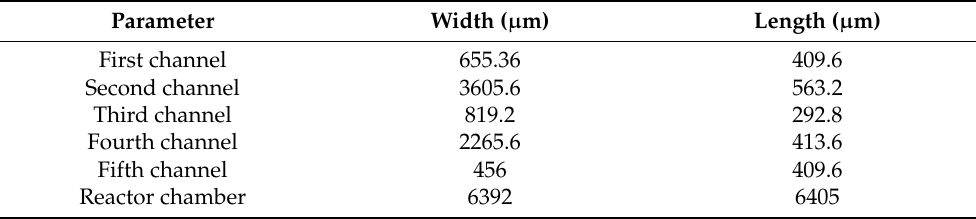
Table 1. Parameters of the microfluidic